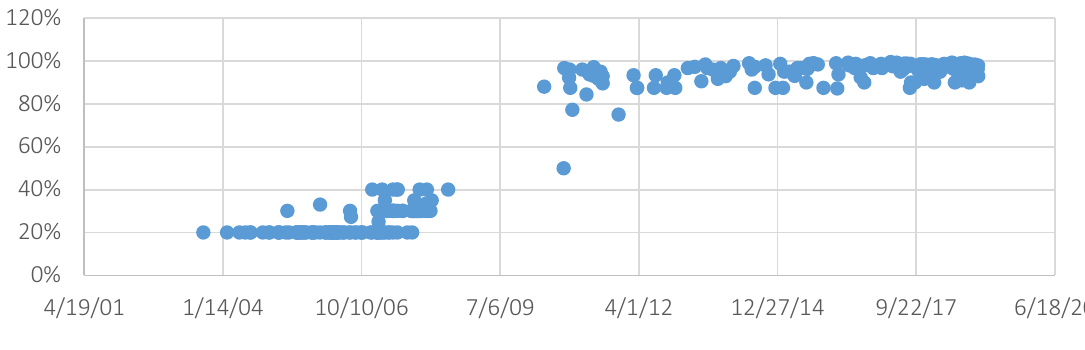
Figure 4. Conversion threshold